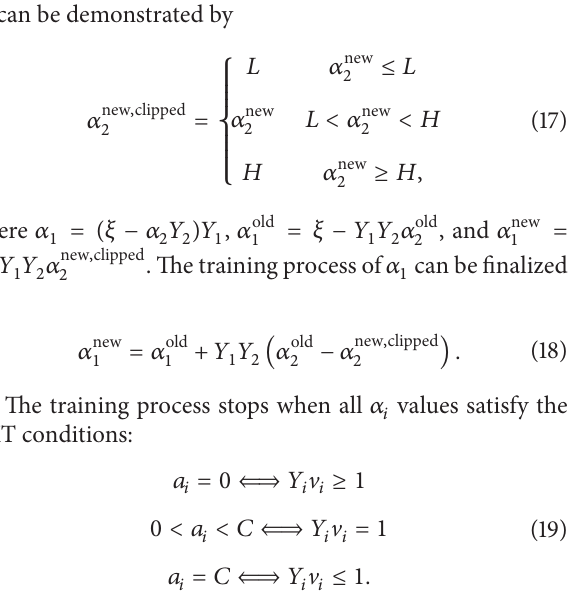
Figure 3: Heterogeneous distribution of the initial instances for C- SVM, Hypothesis 2: when the number of positive instances is equal to the number of negative instances, the positive instances account for a larger